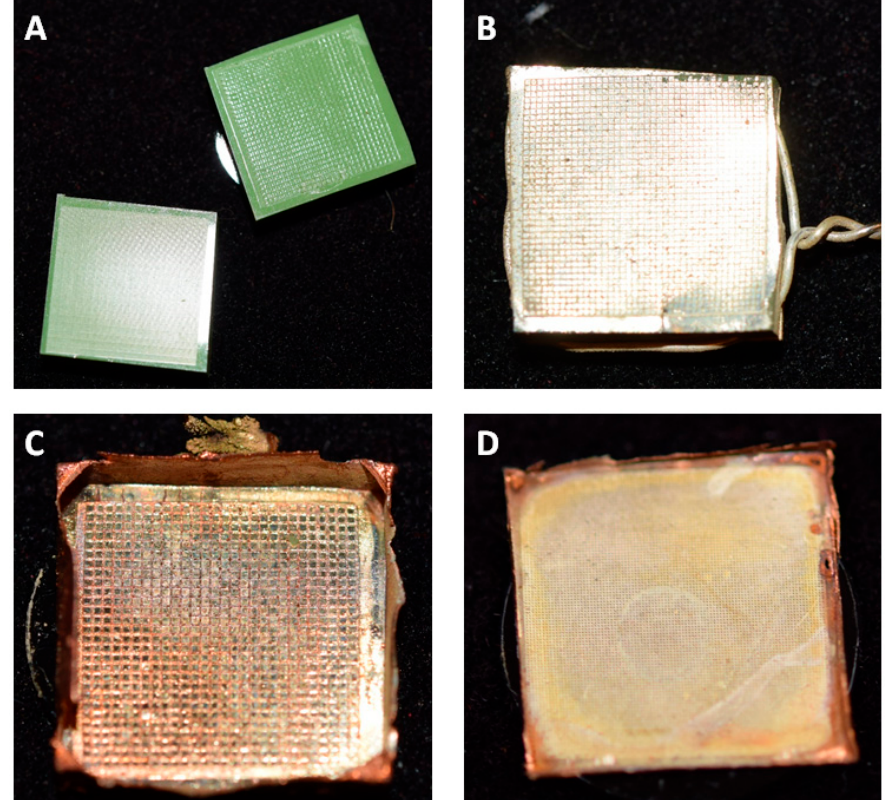
Figure 1. Replication process overview. ( A ) Silicone imprints of surfaces. ( B ) After silver precipitation, a thin layer of silver forms on top of an imprinted structure. ( C ) All-metal positive after electroplating with copper and removal of the silicone mold. The visible, structured surface is a silver–copper matrix copy of the originally imprinted surface. ( D ) All-metal replica after cleaning and gold coating. All samples are approximately 1 cm 2 in size.